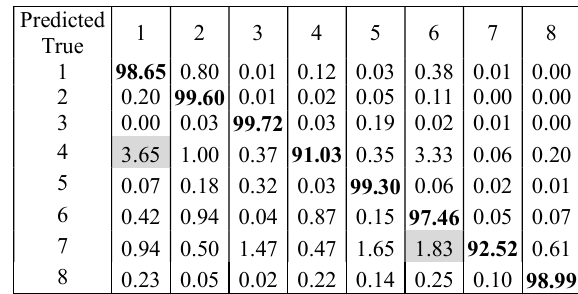
Table 8. Confusion matrix normalized by reference (in %) showing the classification result by feature set C